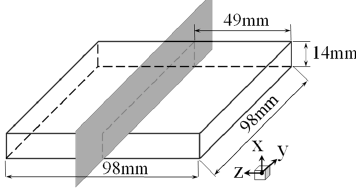
Figure 2. Schematic diagram of specimen size and cutting surface.